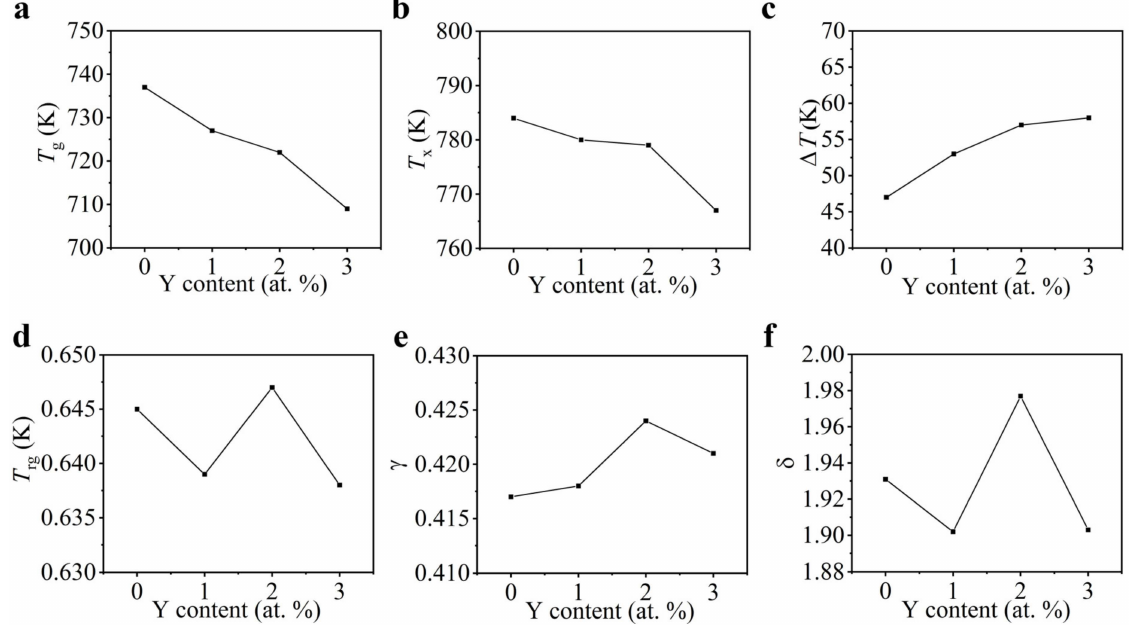
Figure 4. Plots of thermodynamic parameters vs. different yttrium doping contents of the Y0, Y1, Y2, and Y3 alloys: ( a ) T g , ( b ) T x , ( c ) ∆ T , ( d ) T rg , ( e ) γ , and ( f ) δ